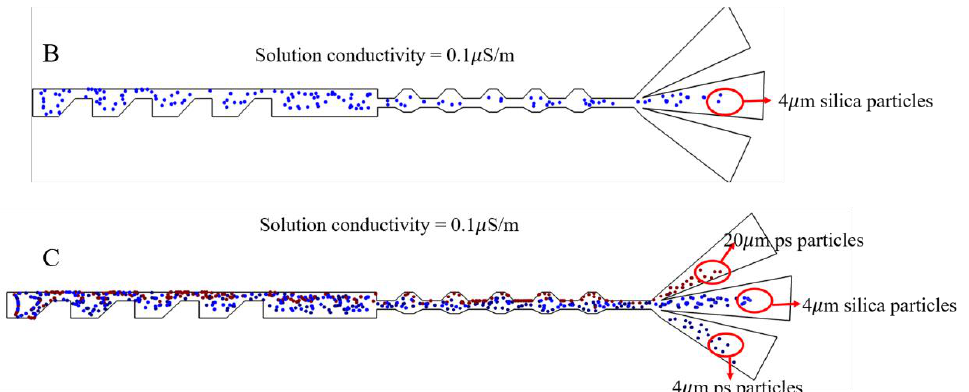
Figure 5. ( A ) Particle trajectory simulation of 20 µ m polystyrene spheres. ( B ) Particle trajectory simulation of 4 µ m silica particles. ( C ) Particle trajectory simulation of 20 µ m polystyrene spheres, 4 µ m silica particles, and 4 µ m polystyrene spheres.